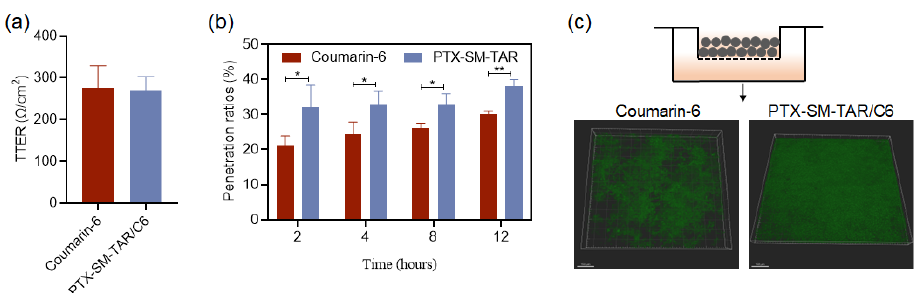
Figure 5. Penetration of PTX-SM-TAR/C6 NPs in the vascular barrier in vitro. ( a ) Barrier resistance value in vitro (mean ± SEM, n = 3). ( b ) Penetrating capacity of PTX-SM-TAR/C6 NPs and coumarin-6 in the lower chamber of the vascular barrier (mean ± SEM, n = 3, * indicates p < 0.05, and ** indicates p < 0.01). ( c ) 3D-images of vascular barrier treated with PTX-SM-TAR/C6 NPs and coumarin-6 for 12 h. Green, coumarin-6. The scale bar is 150 μ m,.